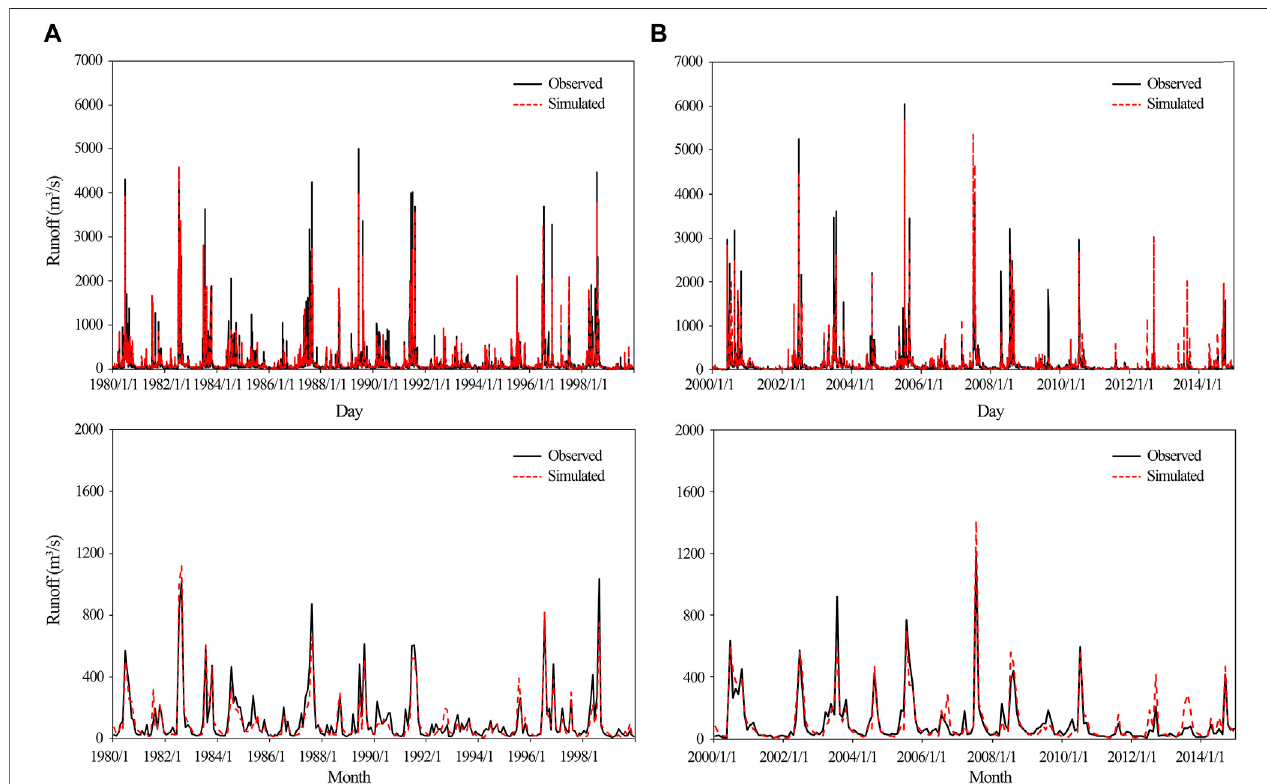
FIGURE 6 | Performance of XAJ model for the calibration (A) and validation (B) periods at daily and monthly scale in the Xixian basin.